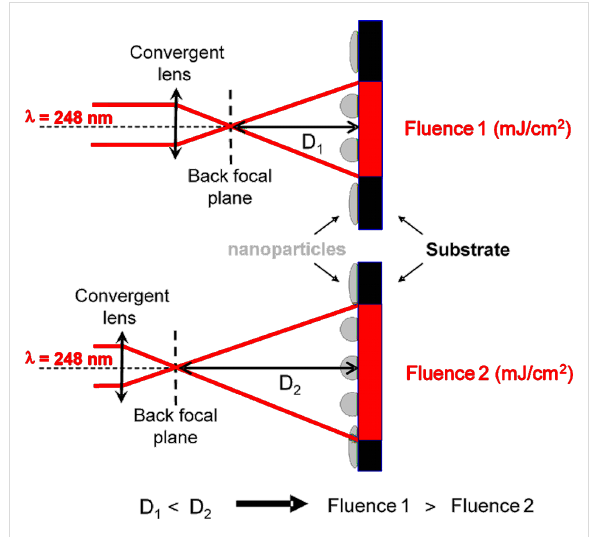
Figure 1: Schematic representation of the experimental setup: the sample is placed behind the back focal plane of a convergent lens. The fluence in the substrate plane is then fixed by the distance D between the sample and the back focal plane of the lens. The longer is D, the lower is the fluence on the